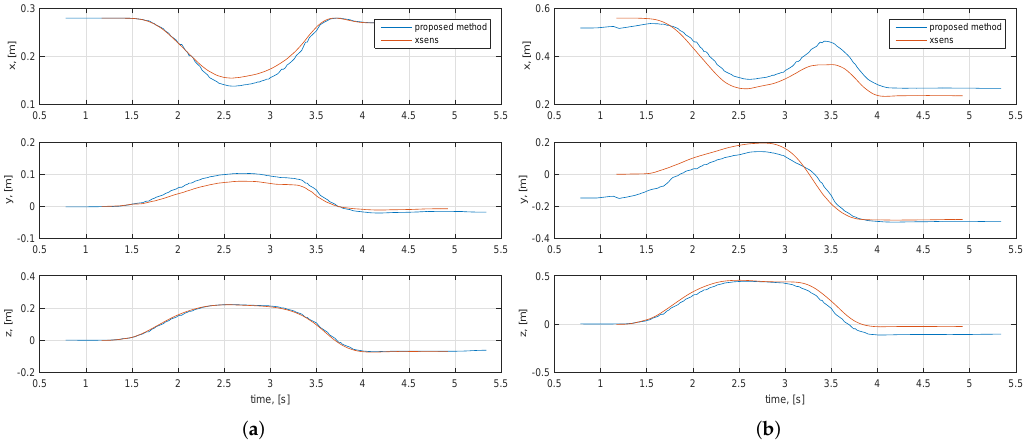
Figure 8. Time evolutions of elbow ( a ) and wrist ( b ) coordinates captured by the Phase-1 system prototype and the Xsens MVN suit